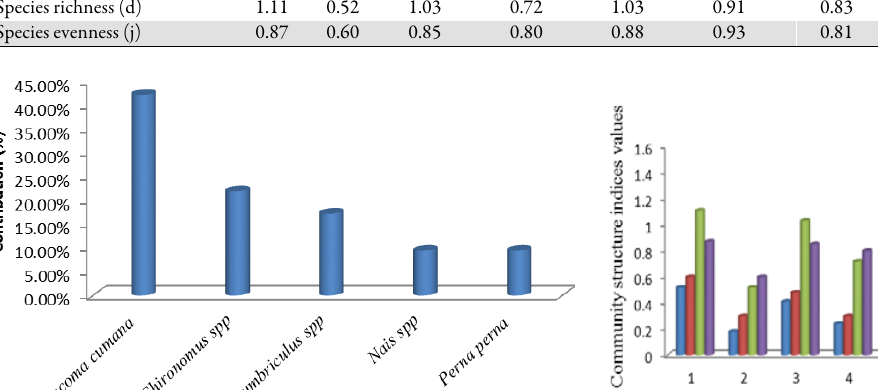
Fig. 5. The percentage contribution of the major macrobenthic invertebrates’ taxa at Ibefun, Ogun state